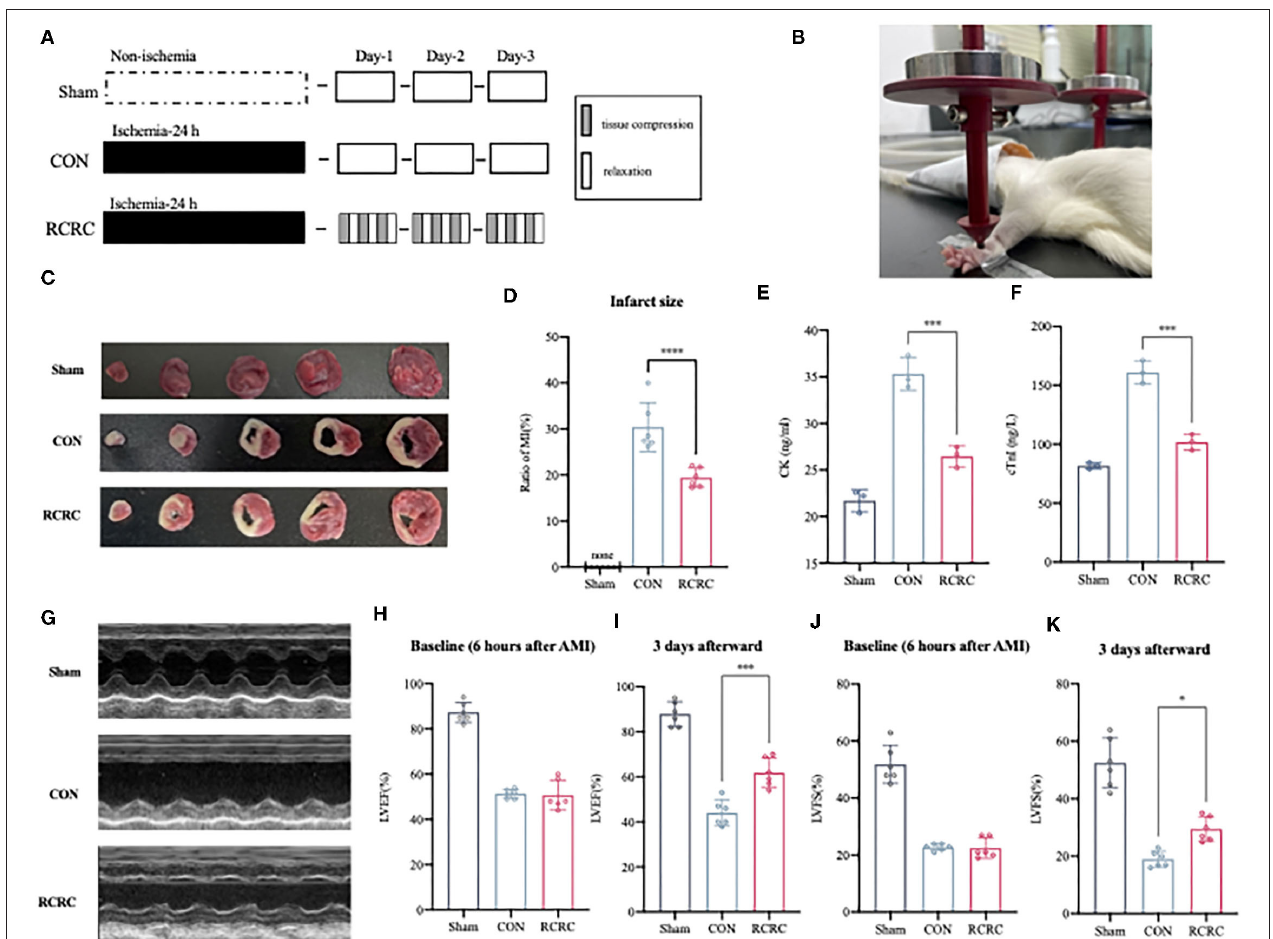
FIGURE 1 | Remote conditioning by rhythmic compression decreases infarct size and ameliorates ventricular dysfunction in a rat model of AMI. (A) Schematic showing the overall animal study design used to test the cardioprotection of remote conditioning in a rat model of AMI. (B) Presentation of remote conditioning on forelimbs of rats. (C,D) TTC staining representing infarct area on multiples slices of an infarct rat heart and quantitative analyses of infarct size after 3 days of remote conditioning, N = 6. (E,F) Serum concentration of CK and cTnI of each group were evaluated after 3 days of remote conditioning, N = 3. (G–K) Representative M-mode echocardiographic images showing LV wall motion of the hearts and LVEF, LVFS measured by echocardiography at 6h (baseline) and 3 days (endpoint) after MI, N = 6. * p < 0.05, *** p < 0.001, **** p < 0.0001 vs.